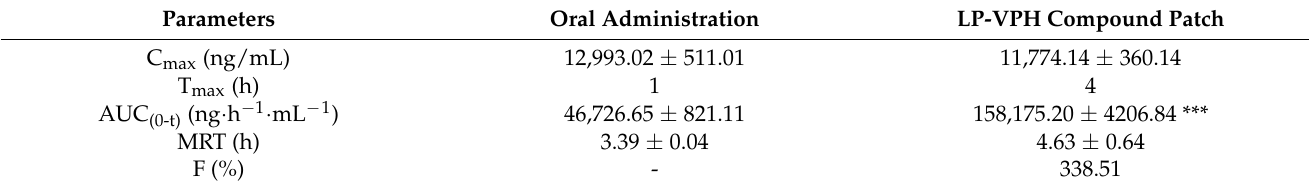
Figure 6. Skin irritation study for the LP-VPH compound transdermal drug delivery system show- ing ( A ) before application of the patch, ( B ) during the application of the optimized patch, and ( C ) after removal of the patch (n = 6).